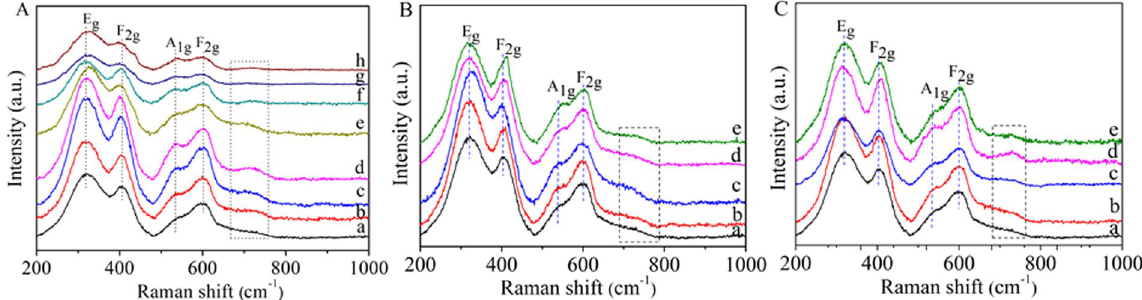
Figure 3. Raman spectra of Gd 2 − x Ca x Zr 2 O 7 + δ ( A ), Gd 2 − x Sr x Zr 2 O 7 + δ ( B ), and Gd 2 − x Ba x Zr 2 O 7 + δ ( C ) powders calcinated at 1500 °C for 4 h: (a) x = 0, (b) x = 0.02, (c) x = 0.05, (d) x = 0.1, (e) x = 0.15, (f) x = 0.2, (g) x = 0.25, (h) x = 0.3.